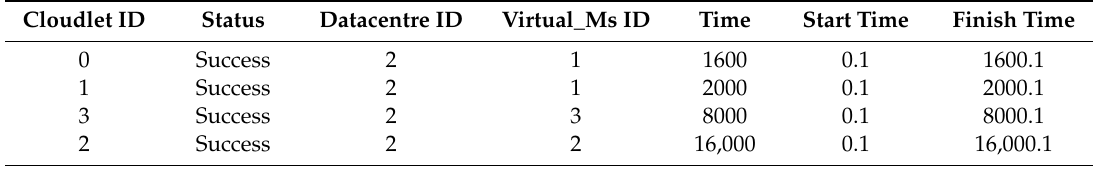
Table 10. Outputs of PPSO algorithm on CloudSim.